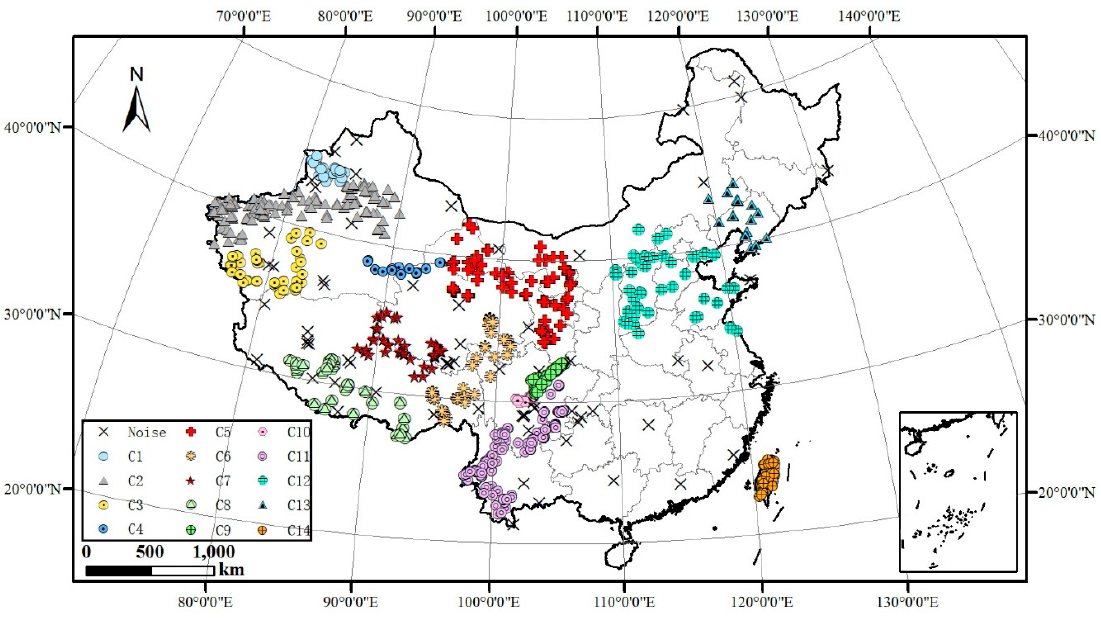
Figure 11. Clustering results for the earthquake database by SCMDOT algorithm in a micro-perspective.